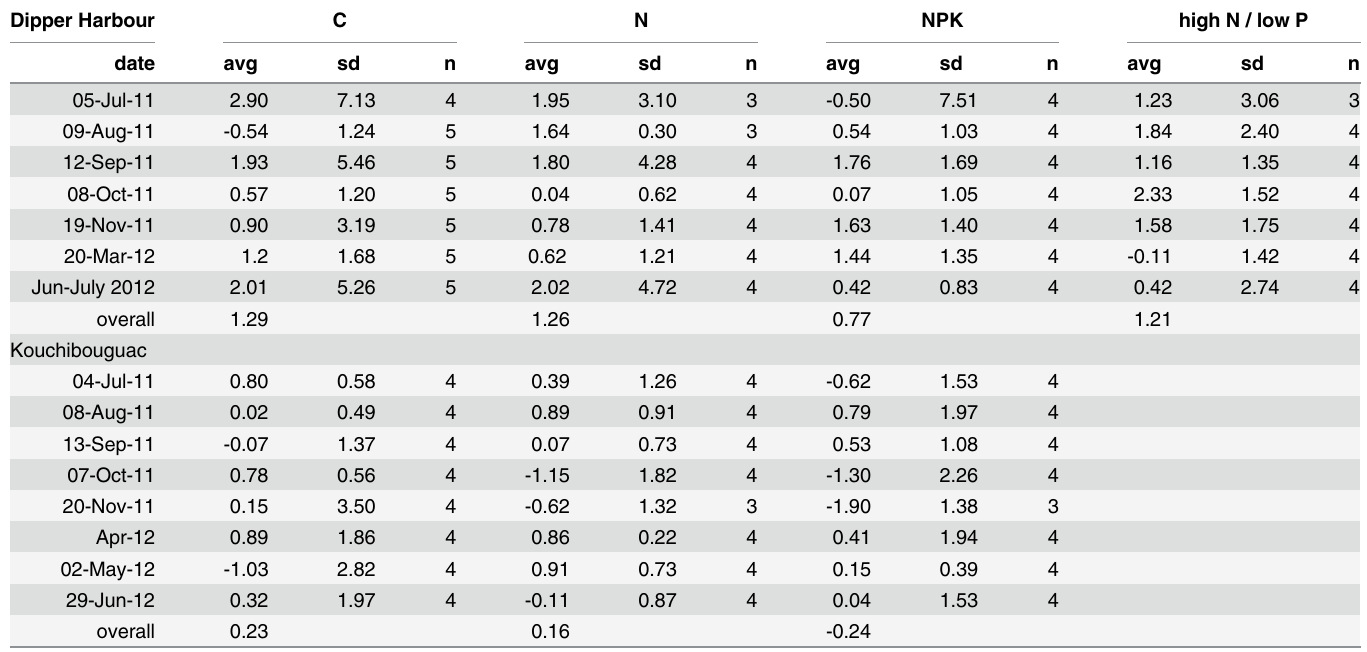
Table 4. Average CH 4 fluxes by sample event in μ moles m -2 hr -1